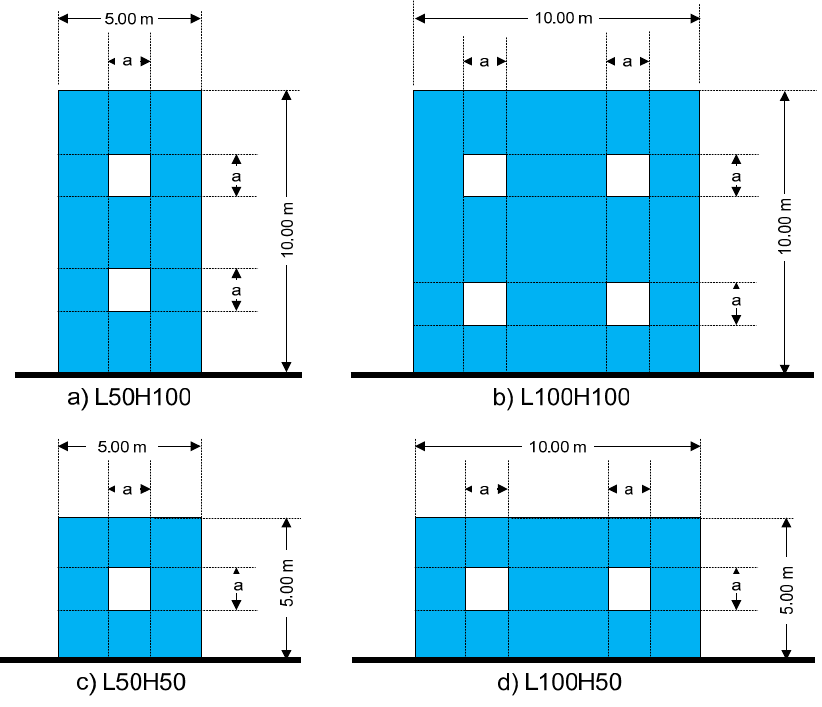
Figure 36. Cases of 2D masonry walls examined. Table 9. Mechanical characteristics of masonry (Page 1981) [236].